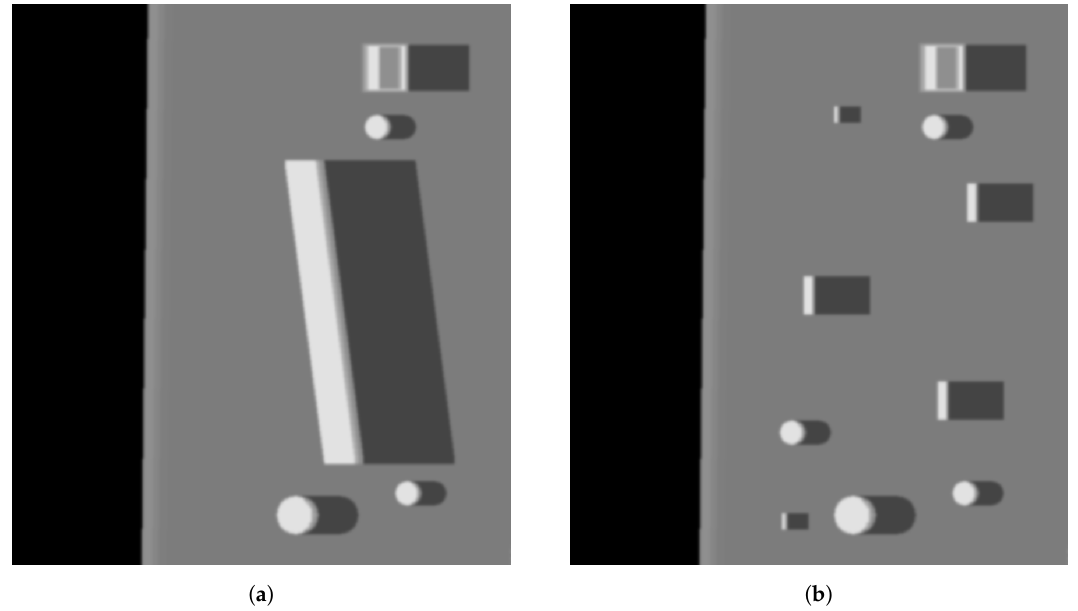
Figure 2. Exemplary synthetic images used as an input. ( a ) Sample image containing larger generated objects; ( b ) Sample image containing smaller generated